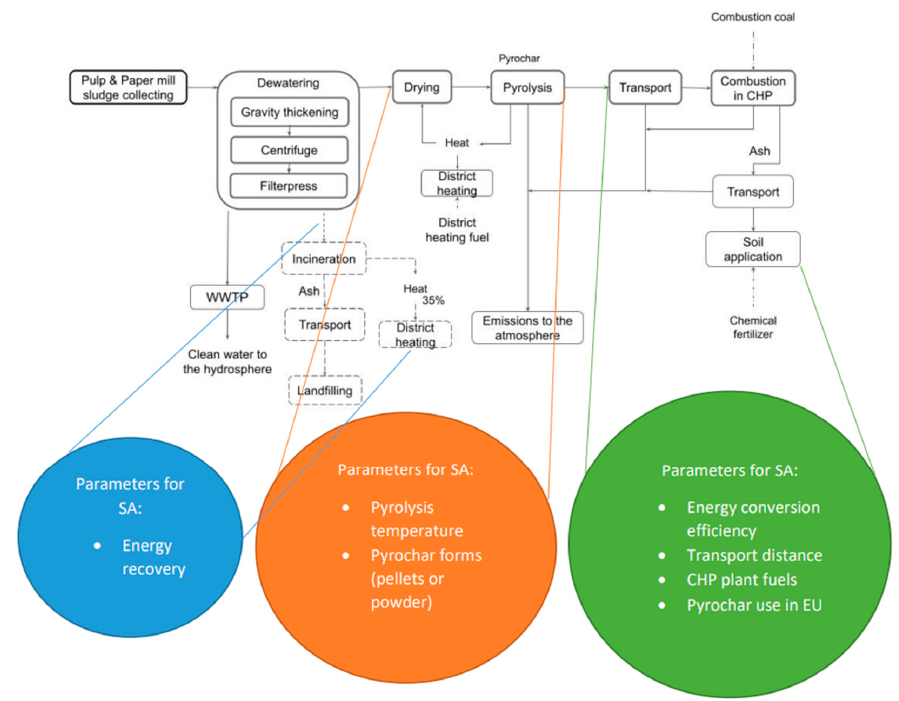
Figure 1. The system boundaries representing the E-LCA study for using pyrochar in CHP plants including the sensitivity analysis parameters. The dashed lines represent avoided processes. The acronyms WWTP, CHP and SA represent wastewater treatment, combined heat and power and sensitivity analysis respectively.